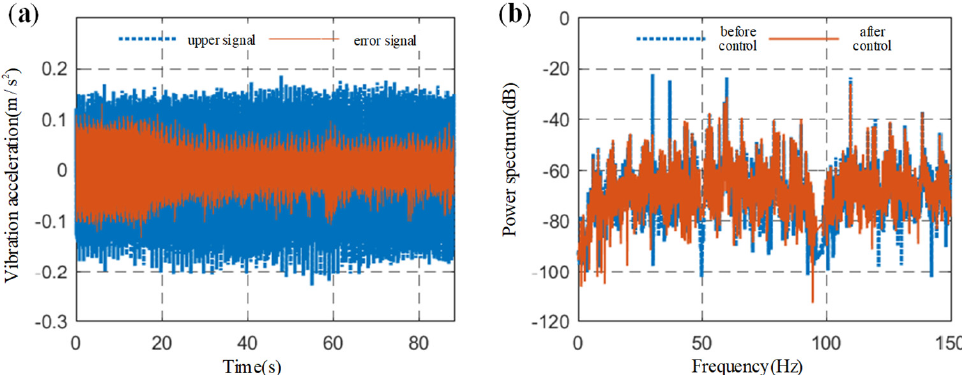
Figure 11. The test results of constant frequency excitation active control (control scheme 1): ( a ) time history diagram; ( b ) power spectrum of error signal.